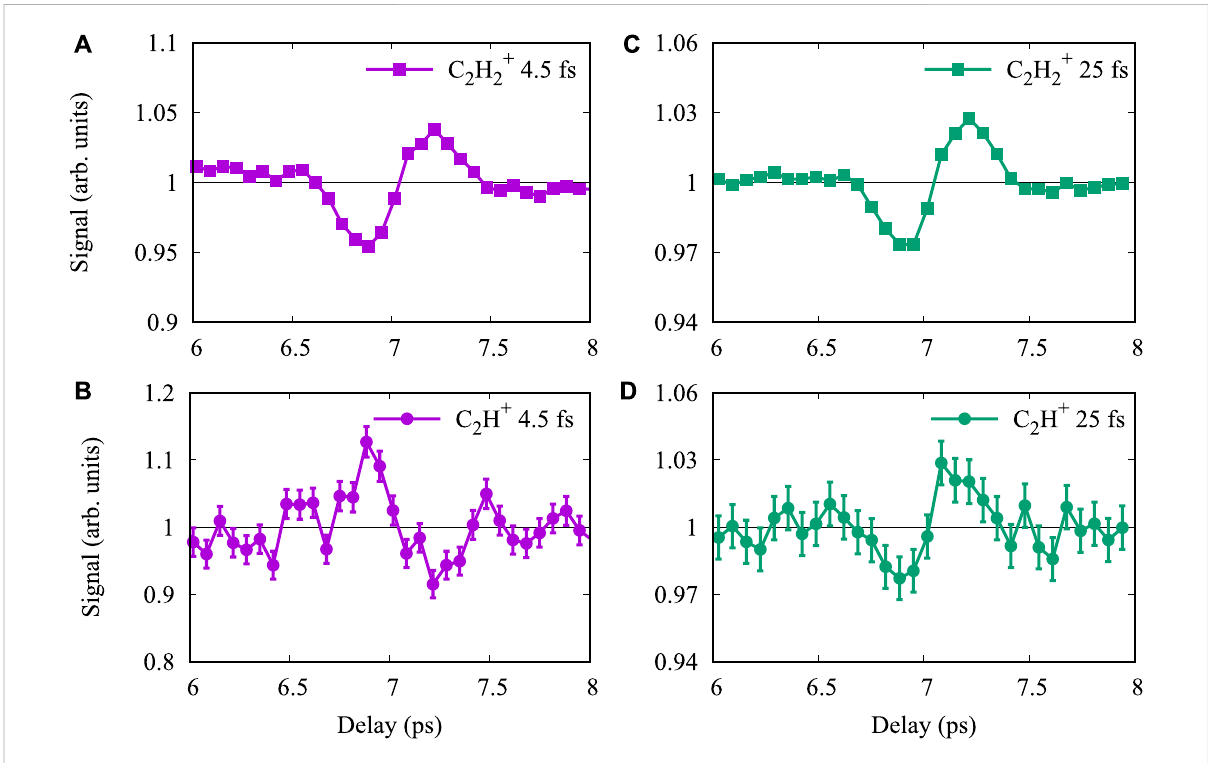
FIGURE 3 Measured ion signals as a function of the time delay between the alignment and the ionization pulse around the half rotational revival. Panels (A,C) are for the signals of non-dissociative C 2 H + 2 , while (B,D) are those for the dissociative of C 2 H + 2 to C 2 H + /H. The measurements with pulse durations of 4.5 fs and 25 fs are shown in (A,B) and (C,D) , respectively. The laser peak intensity is 4 × 10 14 W/cm 2 for both